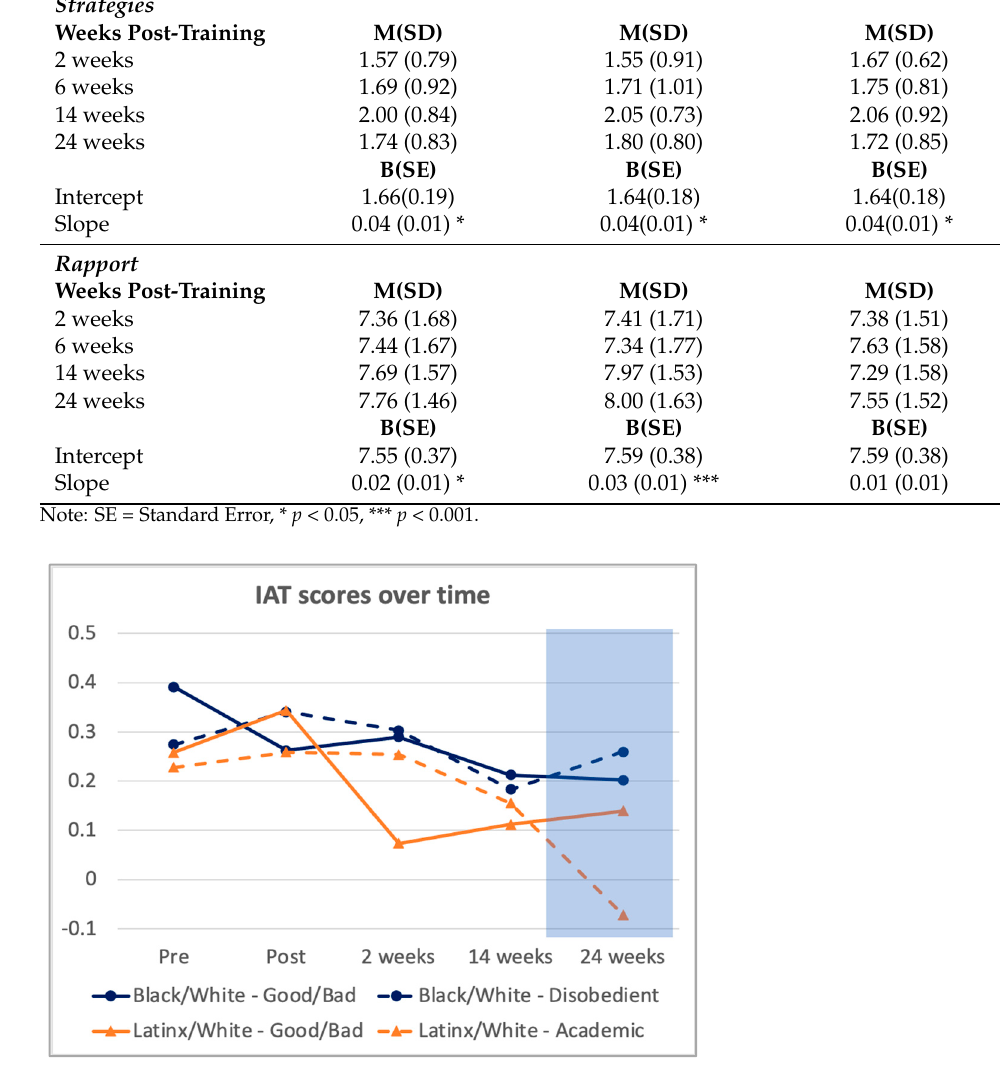
Figure 4. IAT Scores at Each Assessment Timepoint.